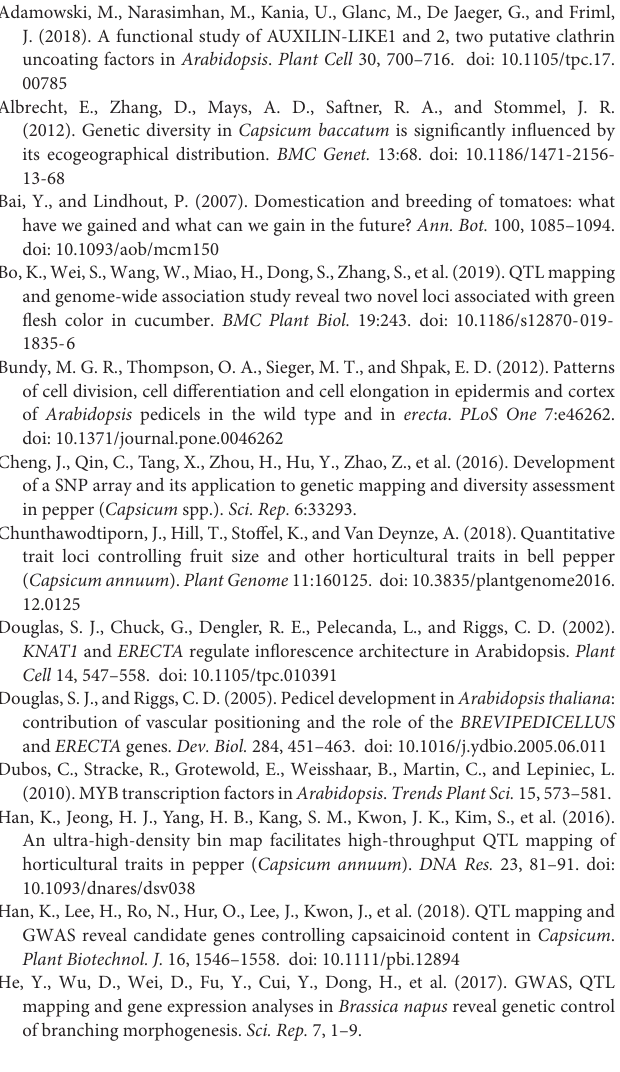
Supplementary Figure 3 | Expression analysis of EFL3-1 and EFL3-2 in UB7 (erect) and GB57 (pendent). (A,B) In the pedicel of ‘UB7 and GB57’, EFL3-1, EFL3-2, and CaActin were not expressed. (C) EFL3-1 and EFL3-2 expression levels were identified. Supplementary Figure 4 | Sequence variation analysis of MYB1 . (A) Nucleotide sequence alignment. (B) Amino acid sequence alignment. Supplementary Figure 5 | Alignment of all EFL3-1 exon sequences. Supplementary Figure 6 | Alignment of all 17UK exon sequences. Supplementary Figure 7 | Alignment of all EFL3-2 exon sequences. Supplementary Figure 8 | Alignment of all 19UK exon sequences. Supplementary Figure 9 | Alignment of all DRG2 exon sequences. Supplementary Table 1 | Pearson correlation matrix of fruit orientation–related traits in the PD lines. Supplementary Table 2 | Primers used in this